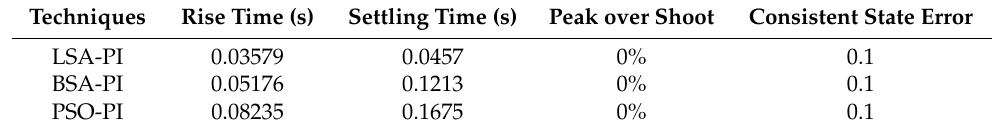
Table 5. Comparison outputs acquire utilizing hybrid optimization and PI controller.